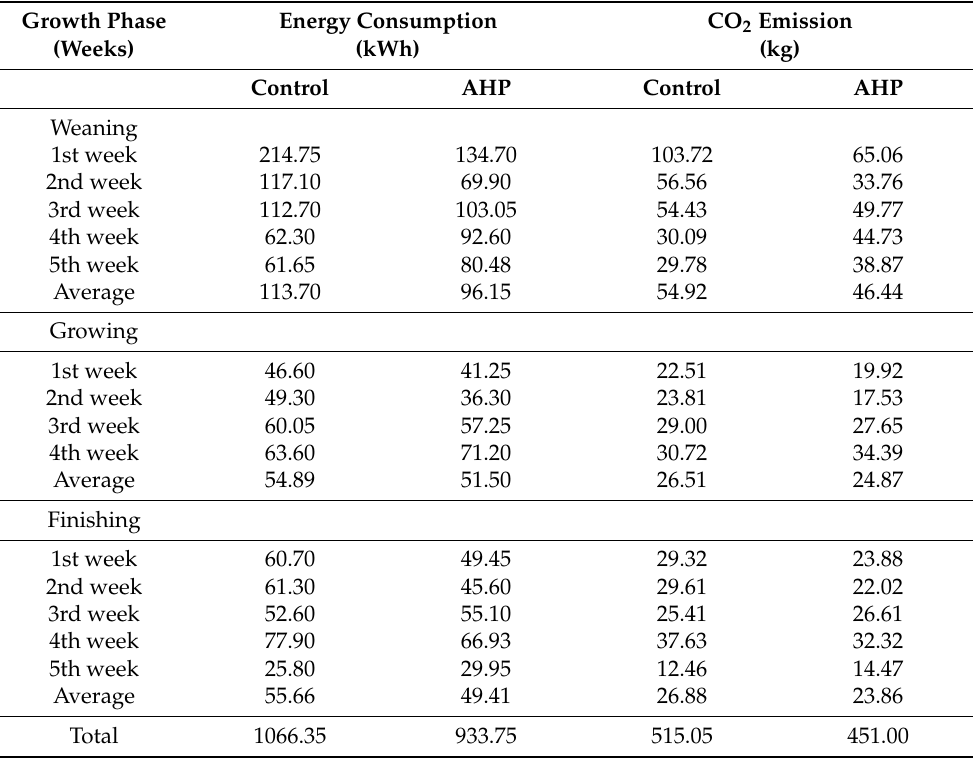
Table 4. Effects of the AHP cooling system on the energy utilization (kWh) and CO 2 emissions (kg) in the pig